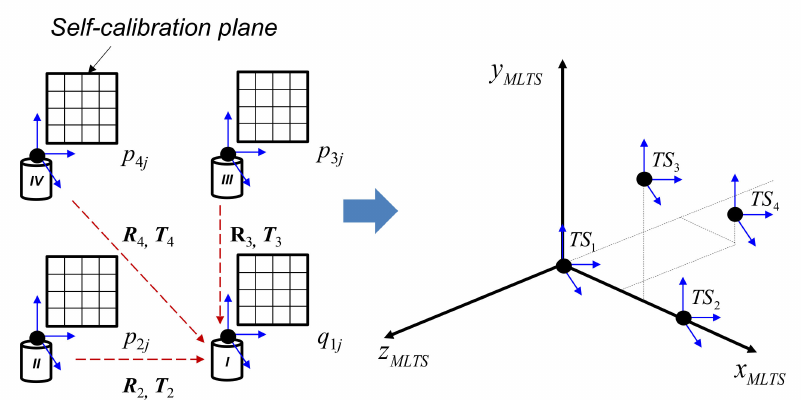
Figure 4. Transformation from local coordinates to global multilateration tracking system (MLTS)